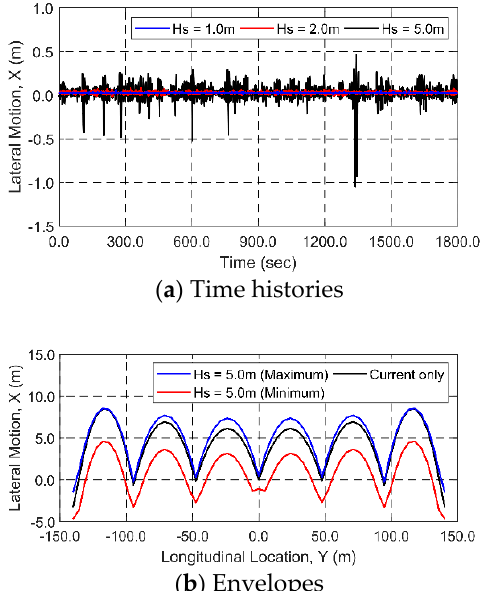
Figure 8. Time histories of the lateral motions of the net at the top-middle location (Y = 0 m, Z = − 23 m) under different wave conditions ( a ) and motion envelopes along the net length at H s = 5.0 m and T p = 10.0 s ( b ) (current velocity = 0.6 m/s).